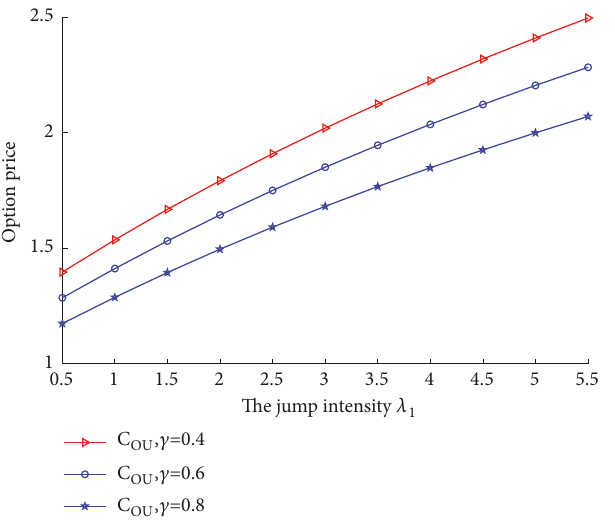
Figure 8: The effect of 𝐶 1 on the option prices.